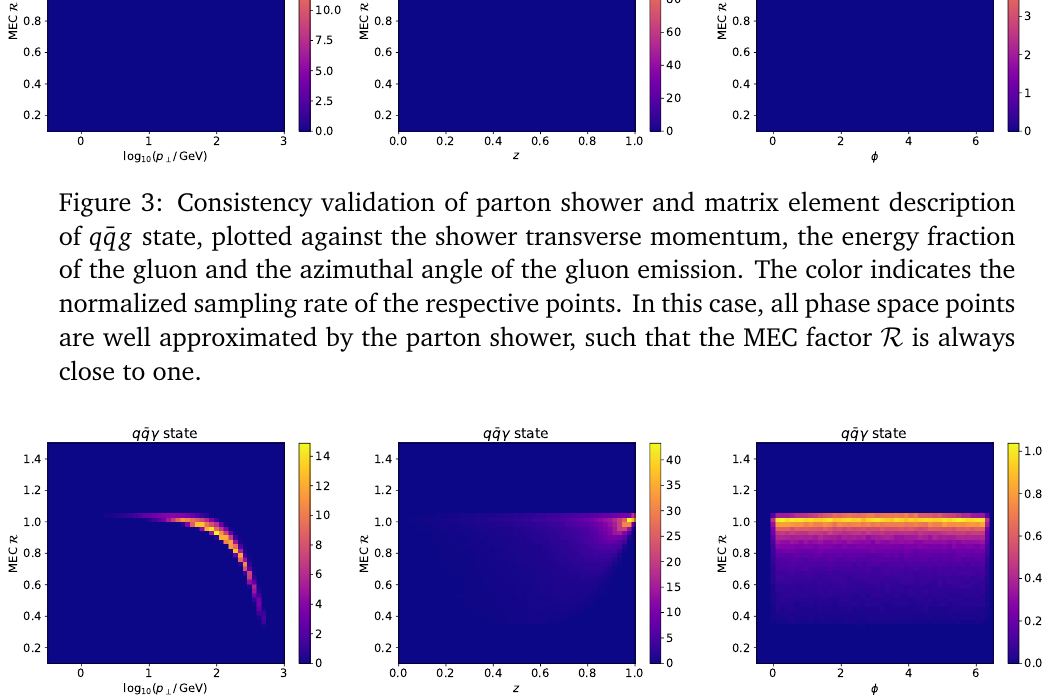
Figure 4: Consistency validation of parton shower and matrix element description of q ¯ q γ state. The MEC factor converges to one for low transverse momenta as R required, but differs for larger transverse momenta, compensating for an enhanced photon emission rate by the